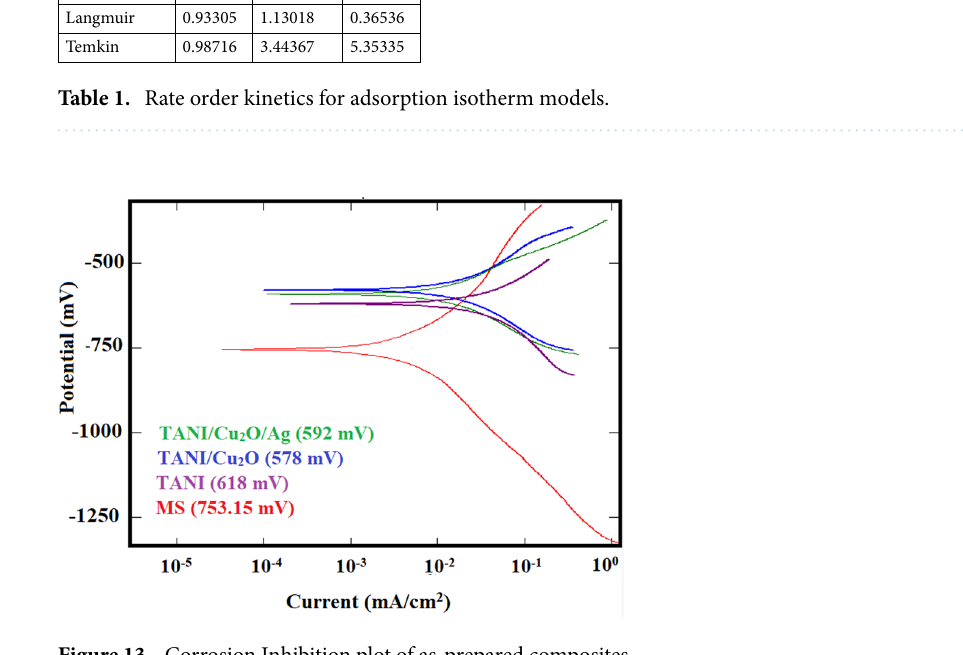
Figure 13. Corrosion Inhibition plot of as-prepared